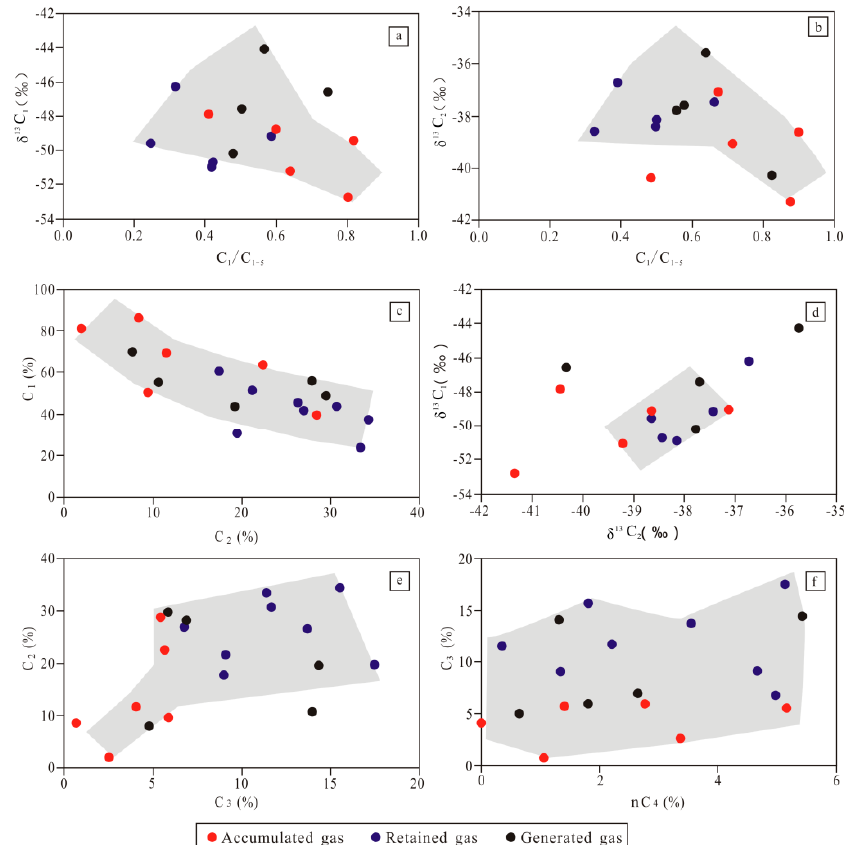
Figure 12. The fractionation of different gas components. ( a ) Relationship between δ 13 C 1 and C 1 /C 1-5 ; ( b ) Relationship between δ 13 C 2 and C 1 /C 1-5 ; ( c ) Relationship between C 1 and C 2 ; ( d ) Relationship between δ 13 C 1 and δ 13 C 2 ; ( e ) Relationship between C 2 and C 3 ; ( f ) Relationship between C 3 and nC 4 .